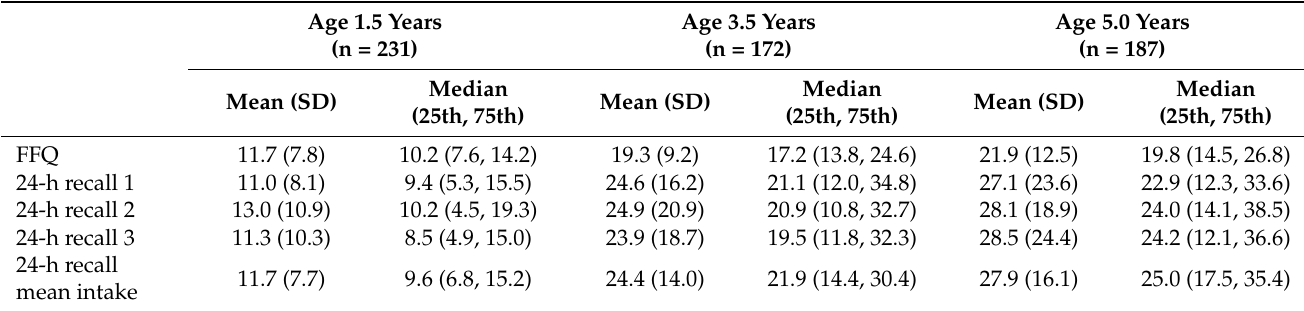
Table 1. Energy-adjusted free sugars intake (g/d) estimated by food frequency questionnaire (FFQ) and three 24-h recalls at ages 1.5, 3.5, and 5.0 years 1 .